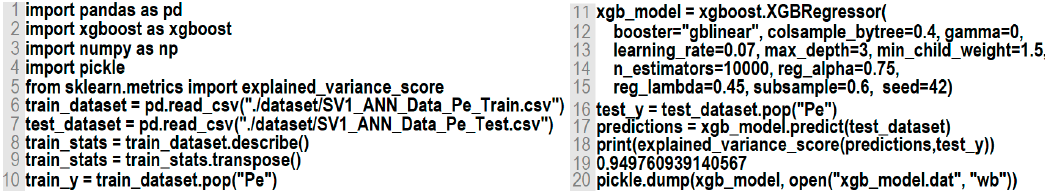
Figure 10. The eXtended Gradient Boosting Regressor (XGBRegressor) training of the gblinear model.